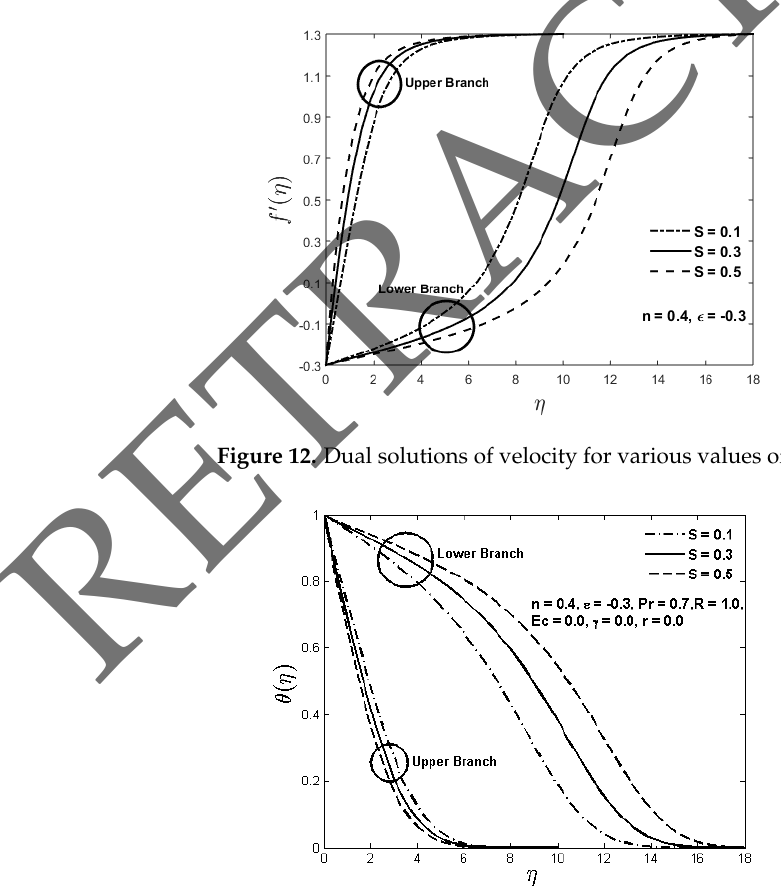
Figure 12. Dual solutions of velocity for various values of S .